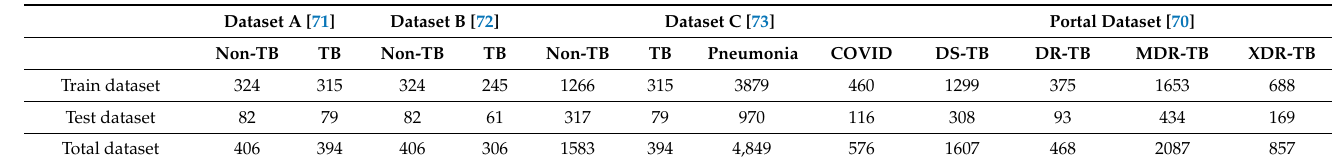
Table 10. Dataset information used to compare with the state-of-the-art methods.